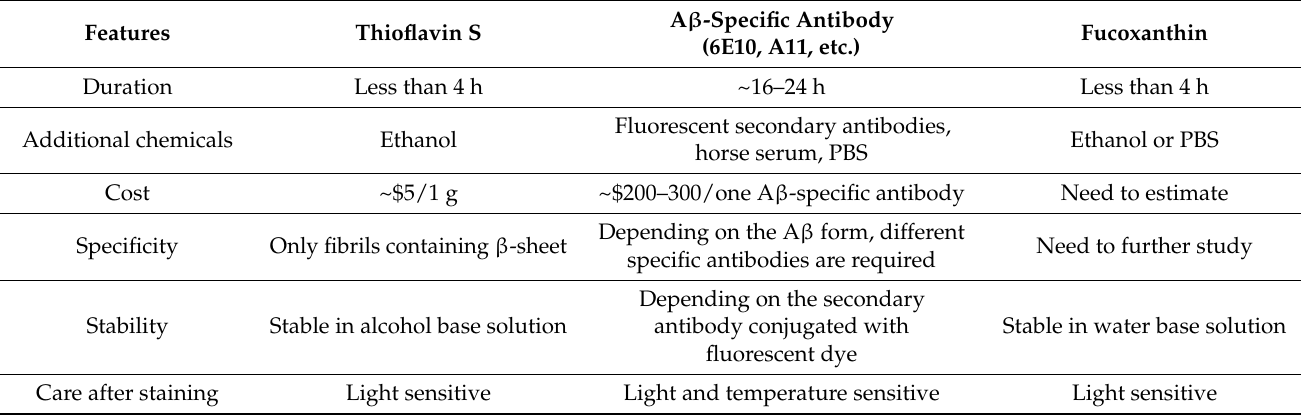
Table 1. Comparison of fluorescent dyes for detecting A β in the brain section.